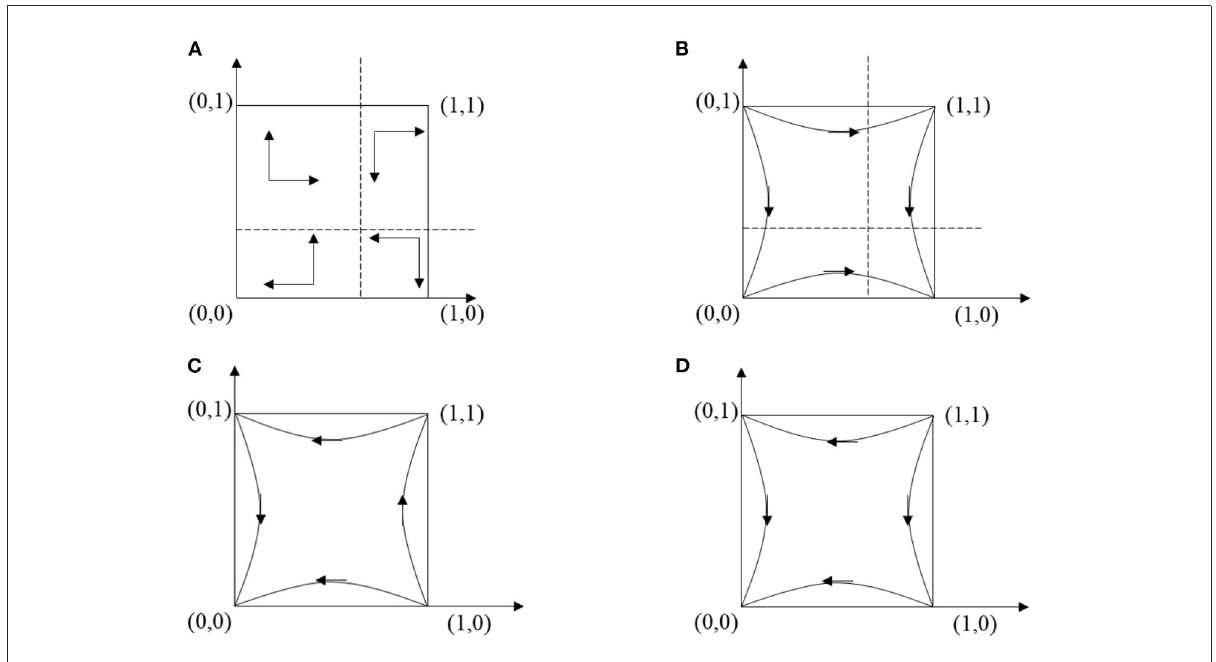
FIGURE2 The dynamic evolution process in different cases. (A) The dynamic evolution process in case 1. (B) The dynamic evolution process in case 2. (C) The dynamic evolution process in case 3. (D) The dynamic evolution process in case